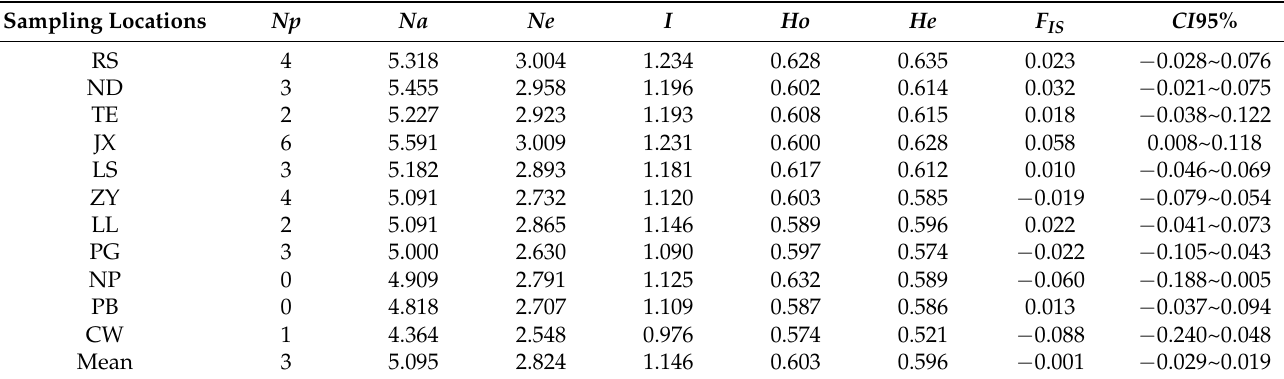
Table 4. Genetic diversity of Chinese fir in 11 sampling